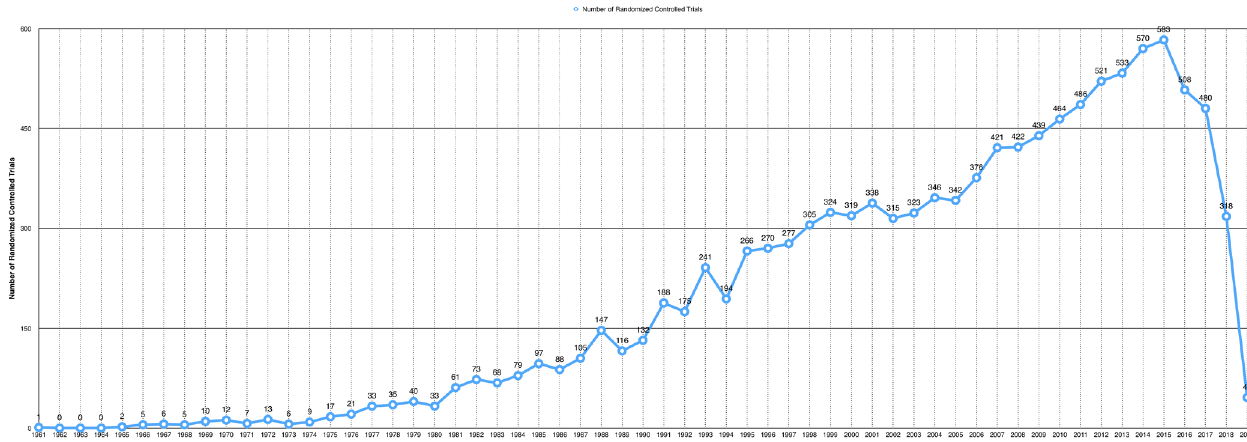
Figure 1. Number of randomized controlled trials published per year in the field of ophthalmology from 1961 to May 2019.